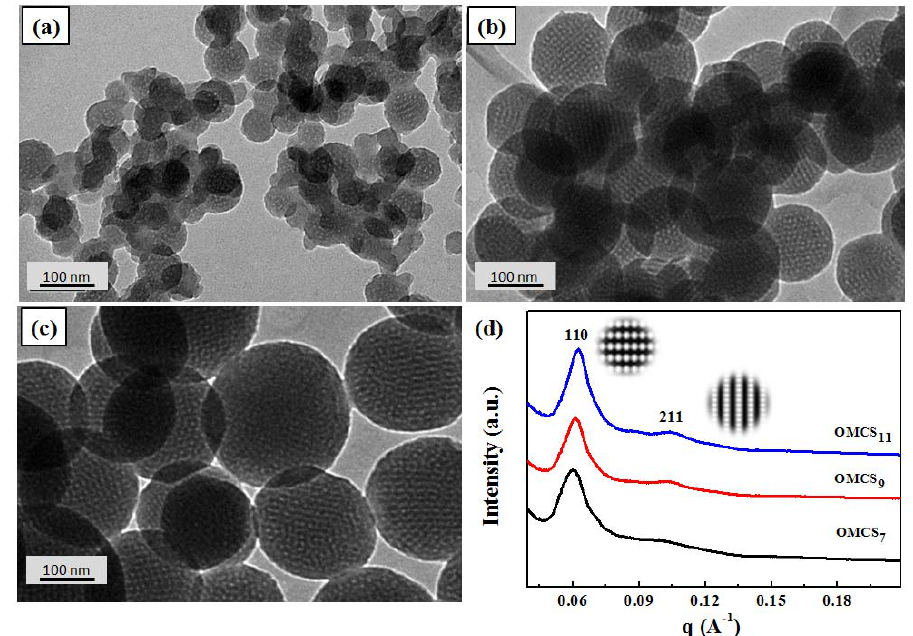
Figure 2. Transmission electron microscopy (TEM) images of ( a ) OMCS 7 , ( b ) OMCS 9 , ( c ) OMCS 11 , and ( d ) small-angle scattering system (SAXS) patterns of OMCS x .